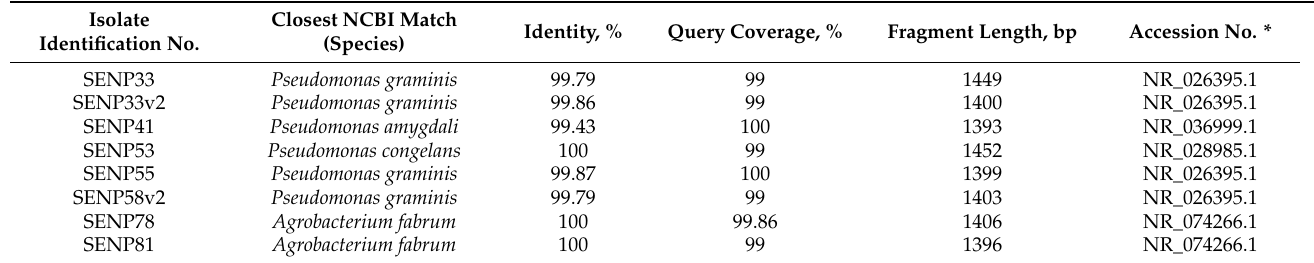
Table A1. Sequencing data of the bacteria isolated in this study.